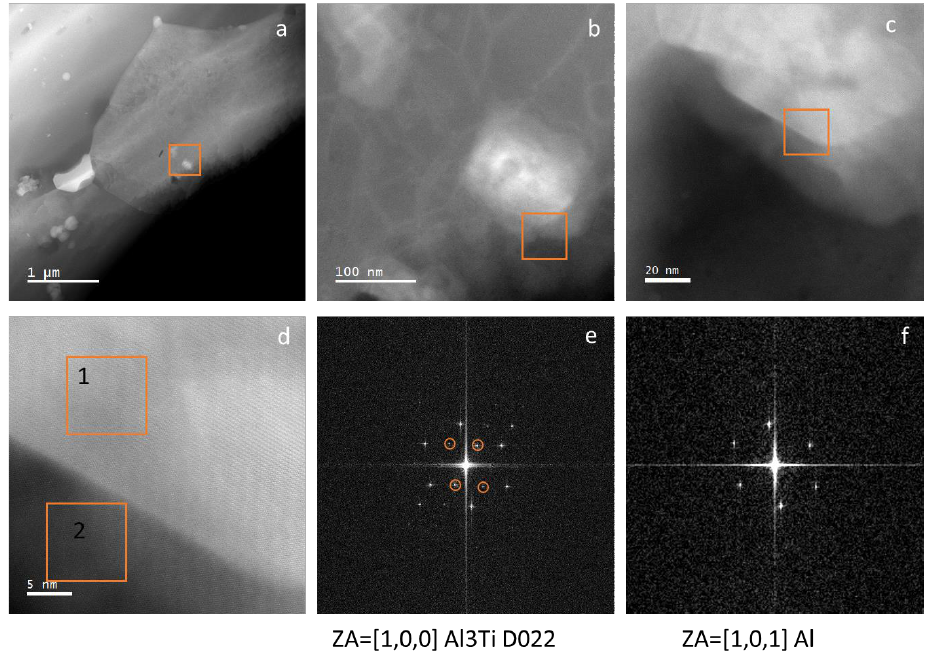
Figure 9. ( a ) High-angle annular dark-field (HAADF)-STEM overview image showing precipitates within an α -Al grain in the as-built part; ( b , c ) HAADF-STEM images showing the area marked in ( a , b ) with rectangles at higher magnification; ( d ) high-resolution HAADF-STEM image of the interface α -Al matrix and Al 3 (Ti,Zr) particle in ( b , c ). ( e ) shows the fast Fourier transform (FFT) from the Al 3 (Ti,Zr) particle (region 1) in ( d ), zone axis is [1,0,0], ( f ) shows the fast Fourier transform (FFT) from the α -Al matrix (region 2) in ( d ). The additional superlattice reflections in ( e ) are circled in orange color.